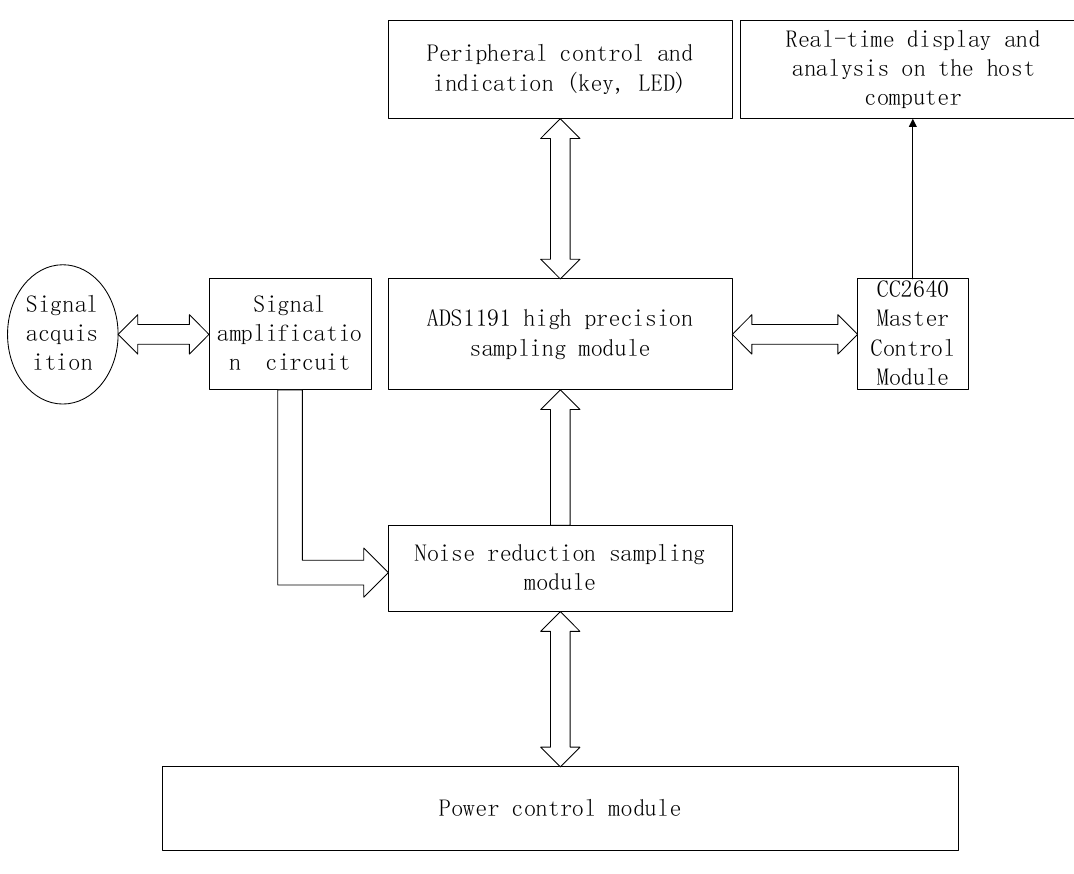
Figure 4. System block diagram of EOG measurement.